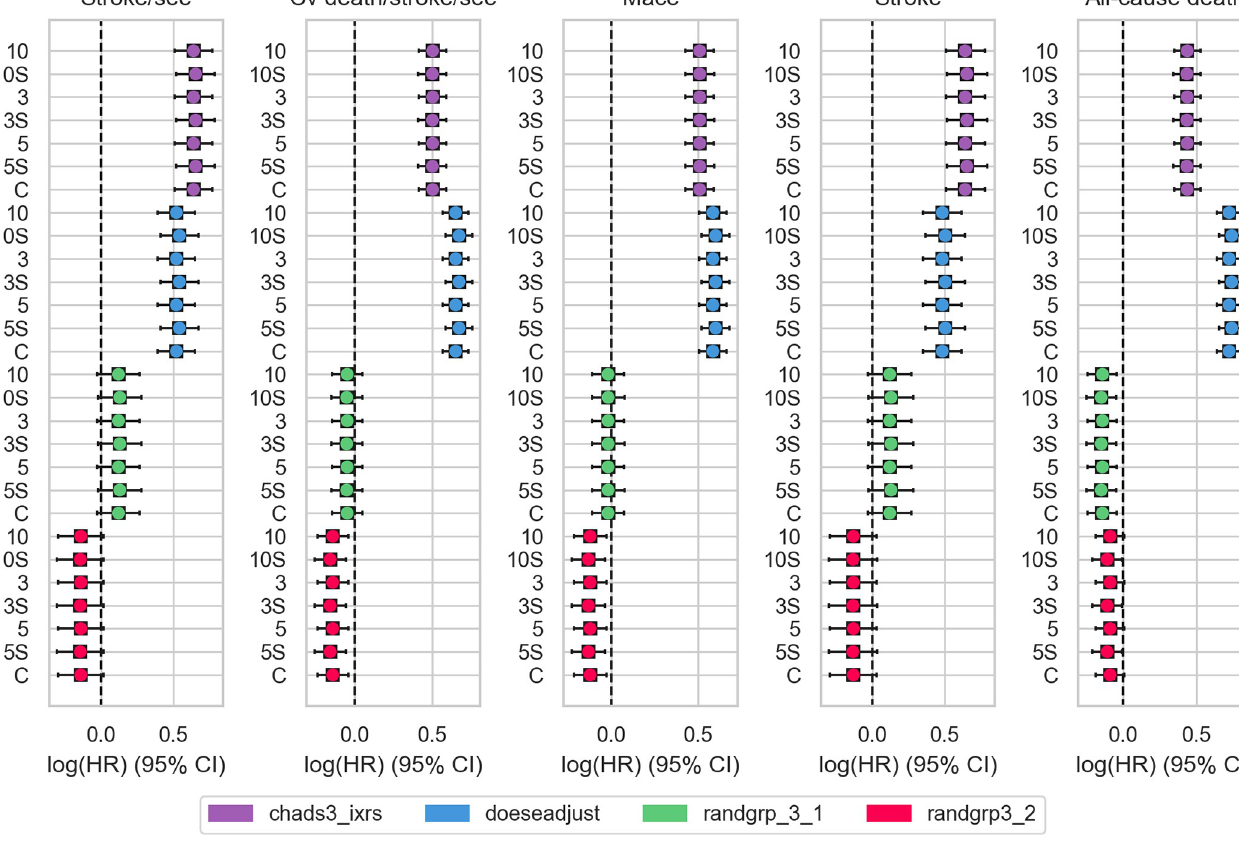
PLOS Digital Health | https://doi.org/10.1371/journal.pdig.0000101 September 6,